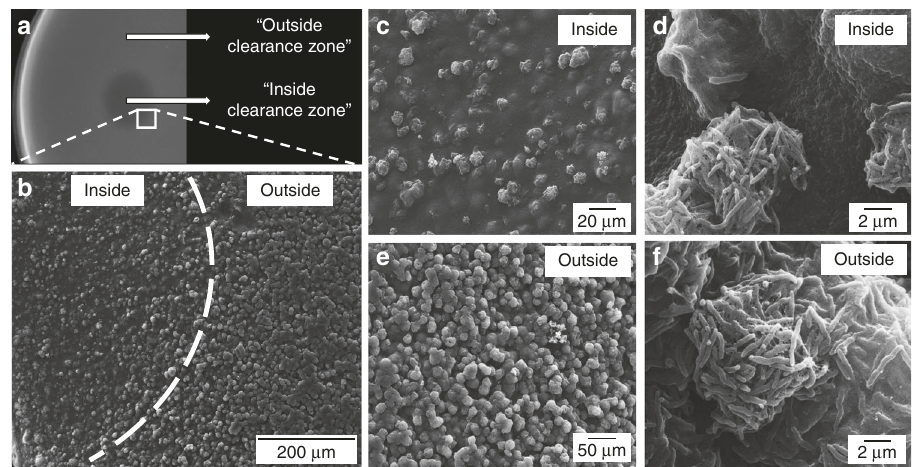
Fig. 3 Scanning electron micrographs depicting C. jejuni HS:19 grown in NZCYM soft agar following exposure to cholera toxin B subunit (CTB). a Clearance zone 24 h after spotting CTB (the white square indicates the location of the excised agar slab). b A low magni fi cation image highlighting the difference in surface structure of the agar slab between the exposed area (left side) and the unexposed area (right side). c , d Increasingly magni fi ed images of the agar surface inside the zone of clearance. e , f Increasingly magni fi ed images of the agar surface outside the zone of clearance. Images are representative of 3 replicate experiments